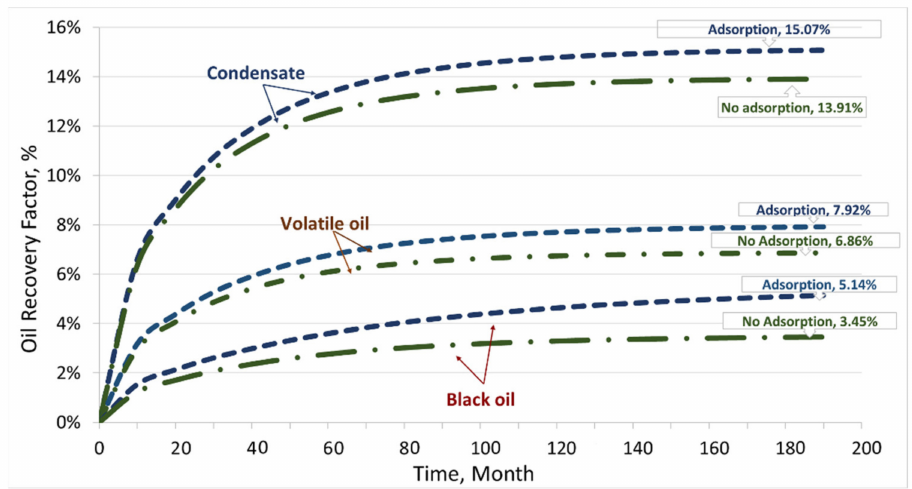
Figure 5. Desorption impact on oil recovery during primary